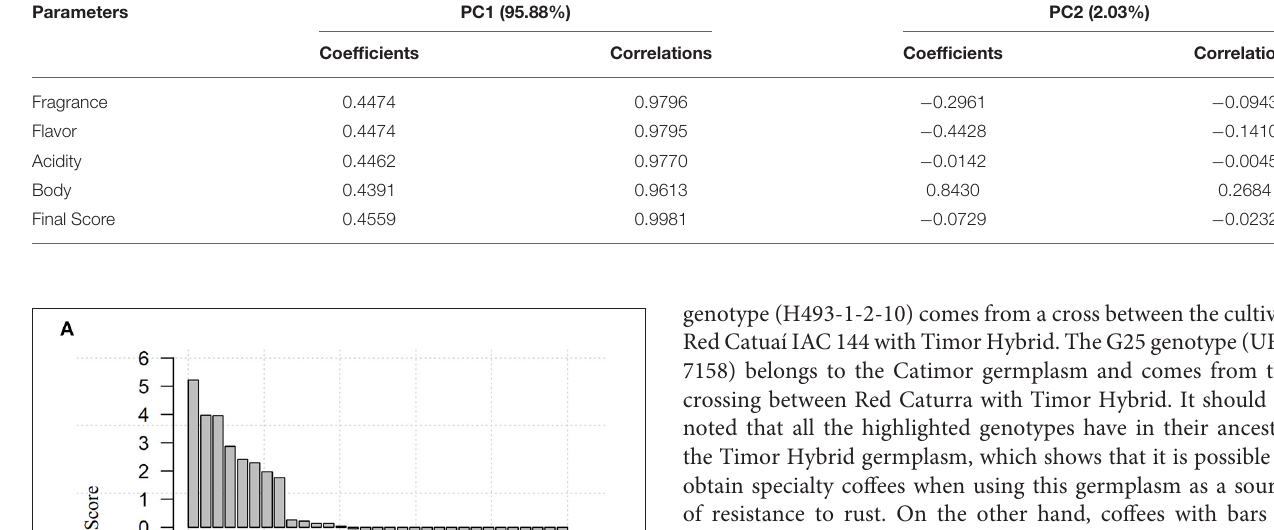
TABLE 2 | Correlations between the evaluated parameters (final score and sensory attributes) with the first two main components and the respective coefficients of each parameter with the main component. Parameters